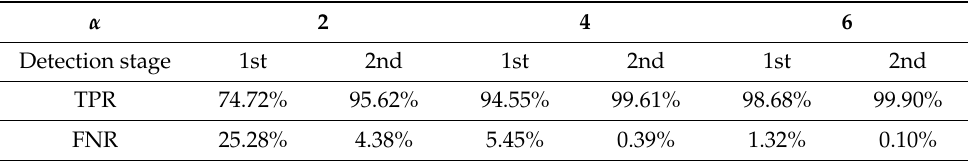
Table 3. TPR and FNR values for the first and second stage detections.